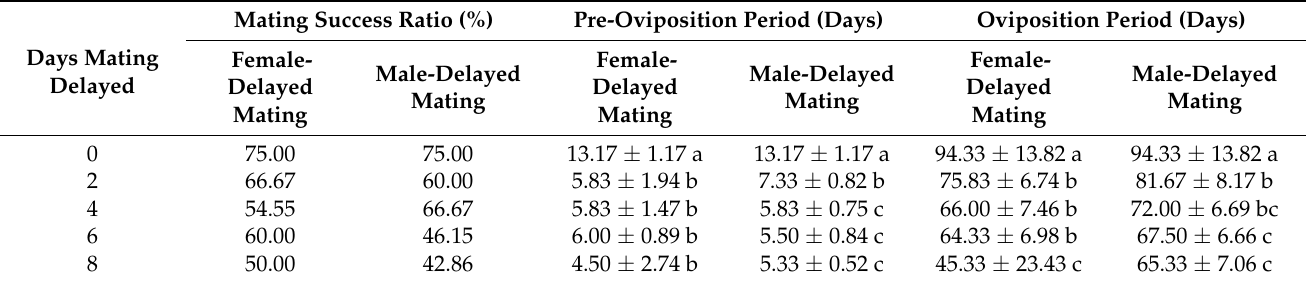
Table 1. Effect of delayed mating on the mating success, pre-oviposition period, and oviposition period of H. vigintioctopunctata .